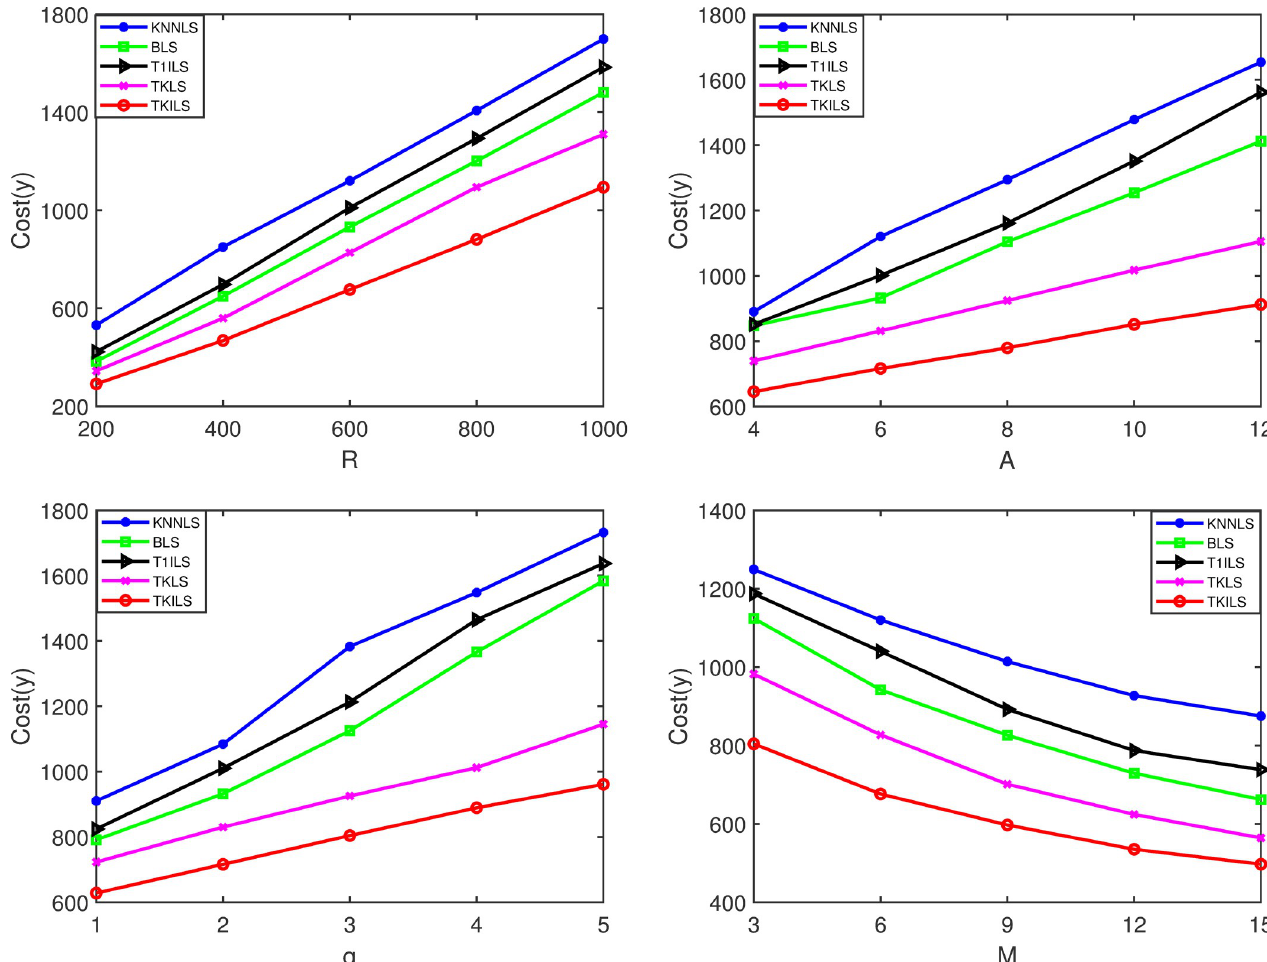
Fig 10. Cost results on the real datasets. Note: Fig 10(A)–10(D) are the cost results for varying | R |, | A |, | q | and | M |, on the real datasets, respectively.